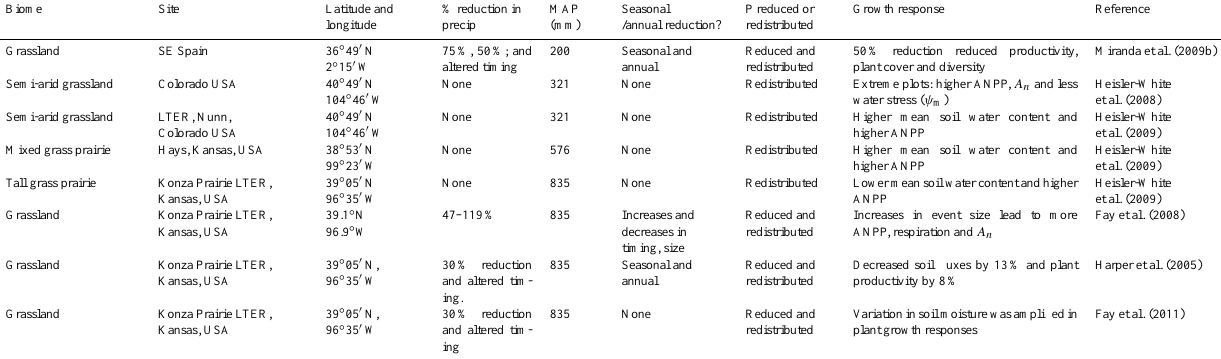
Table 2. Responses of vegetation to extreme precipitation. Biome, site location, latitude and longitude, experimental reduction in precipita- tion, Mean Annual Precipitation (MAP), and description of whether experimental reduction was annual (across the entire year) or during one season, in addition to the measured response and source reference. LTER stands for “Long Term Ecological Research” site. Results represent a selection of studies and are not a comprehensive list. Abbreviations: ANPP = Above-ground net primary productivity; A n =